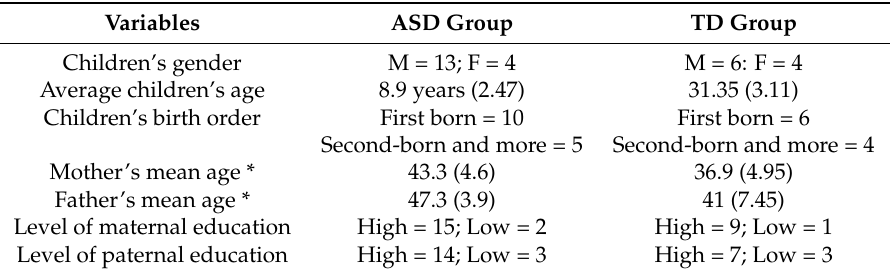
Table 3. Description of the sample divided by children’s group. Standard deviation is in the bracket. Note that for the level of education “high” means at least 13 years of education whereas “low” indicates 5–8 years of